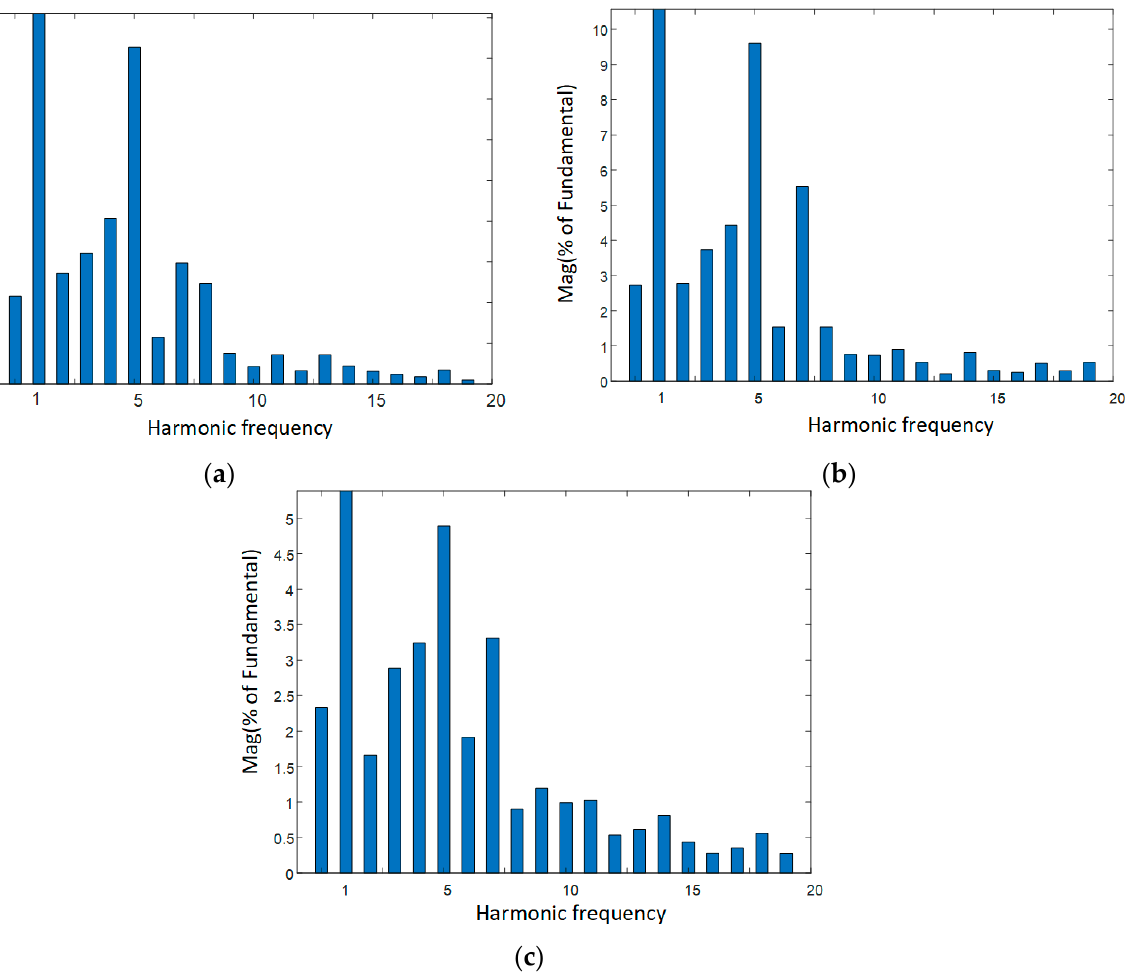
Figure 14. Fast Fourier transform (FFT) waveform: ( a ) No dead zone compensation; ( b ) the traditional linear dead zone compensation; ( c ) the improved linear dead time compensation.